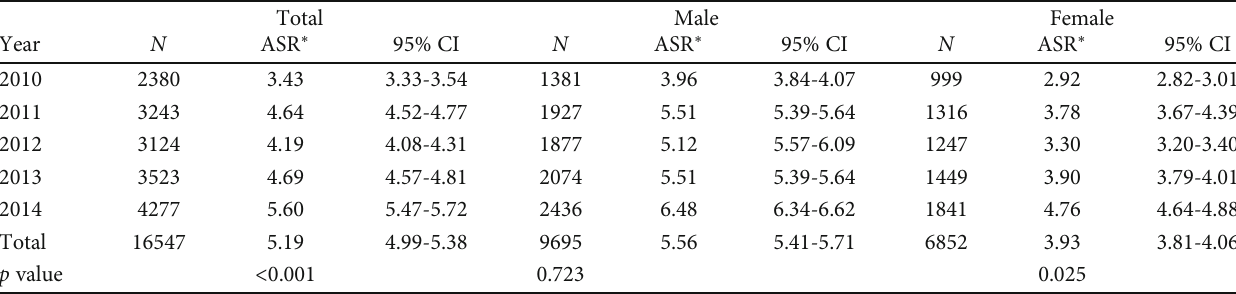
Table 4: Age-standardized incidence rate